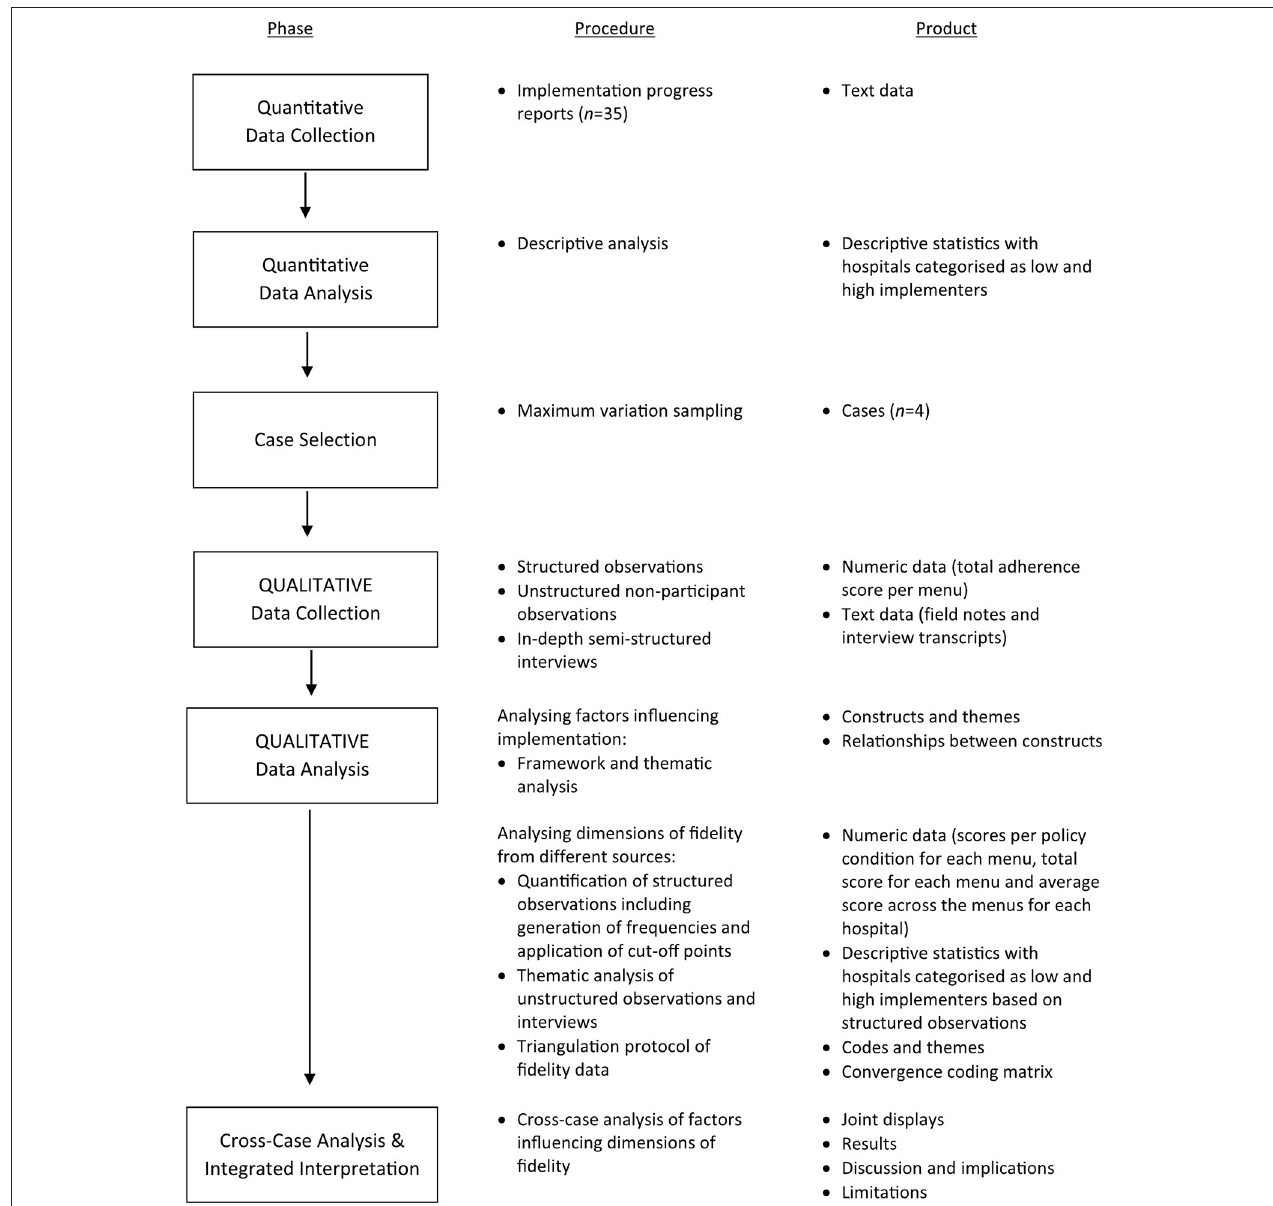
FIGURE 1 | Diagrammatic representation of the mixed methods sequential explanatory